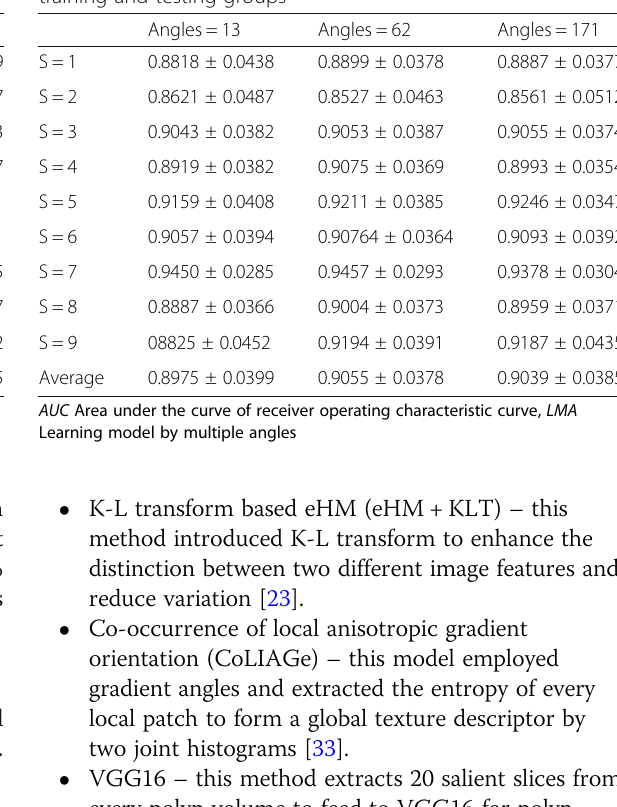
Table 5 AUC scores of three CM sets with nine different strides for LMD + LMS where D represents displacement